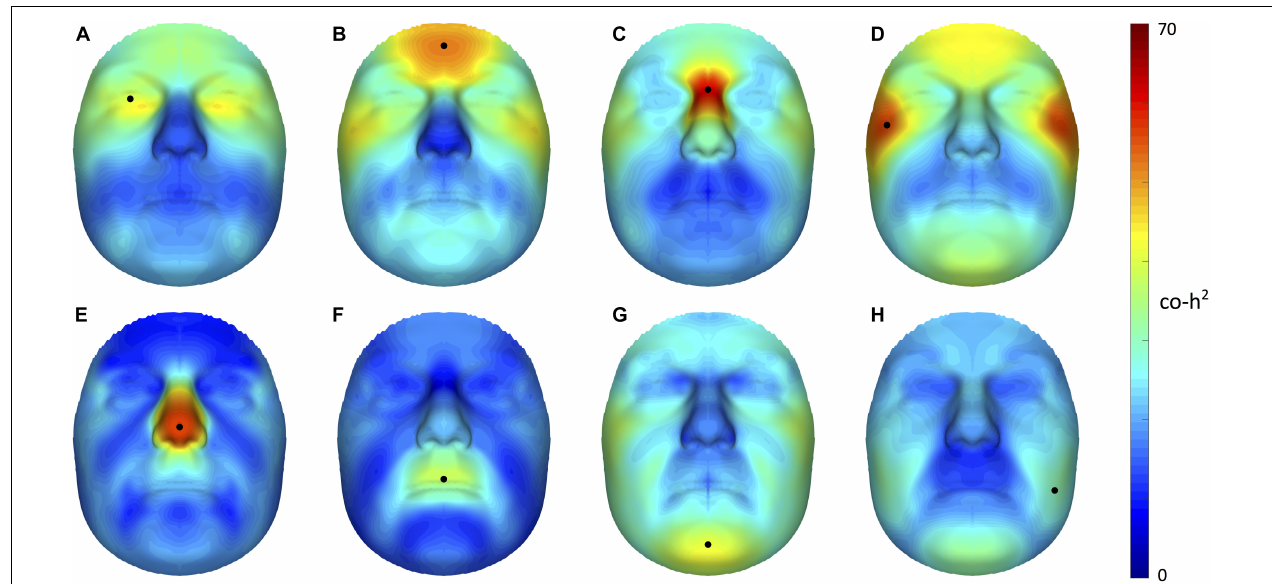
FIGURE 2 | Facial maps of co-heritability. 3D pairwise landmark co-heritability (%) of the (A) orbital region, (B) forehead, (C) nasion, (D) zygomas, (E) nasal tip (F) upper lip, (G) chin and (H) cheeks. Landmarks of interest are indicated by a black dot, each representing the quasi-landmark in fathers that was used to predict facial variation in children for the corresponding as well as all other quasi-landmarks. The red-blue spectrum represents regions of high and low co-heritability, respectively. The maximum value was set to 70% for visualization purposes.